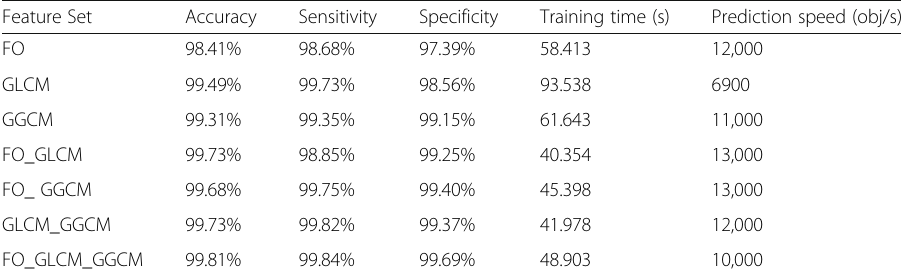
Table 4 The performances of SVM classifiers based on different kinds of features Feature